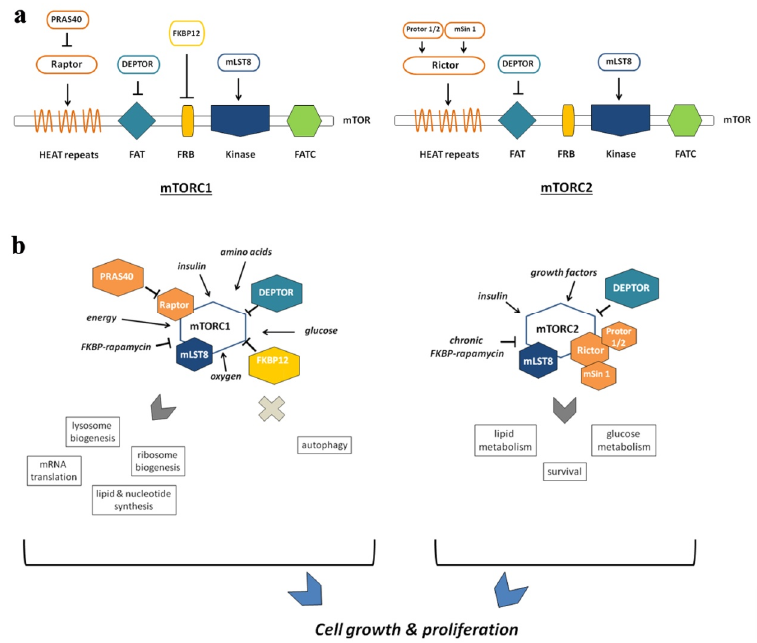
Figure 2. mTORC1 and mTORC2 domains and interactors. ( a ) Deptor, DEP domain-containing mTOR-interacting protein; FAT, FKBP/ATM/TRRAP; FATC, FRAP/ATM/TRRAP/Carboxy terminal; FKBP-12, FK506-binding protein-12; FRB, FKBP, rapamycin-binding; HEAT, Huntingtin/Elongation factor 3/A subunit of protein phosphatase-2A/ TOR1; mLST8, mammalian lethal with SEC13 protein 8; mSin1, mammalian stress-activated protein kinase interacting protein 1; mTOR, mechanistic target of rapamycin; mTORC1, mTOR complex 1; mTORC2: mTOR complex 2; PRAS40, proline-rich AKT substrate 1 40 kDa; Protor 1/2, protein observed with Rictor; Raptor, regulatory-associated protein of TOR; Rictor, rapamycin-insensitive companion of TOR. ( b ) mTORC1 and mTORC2 complexes and their role in cell growth and